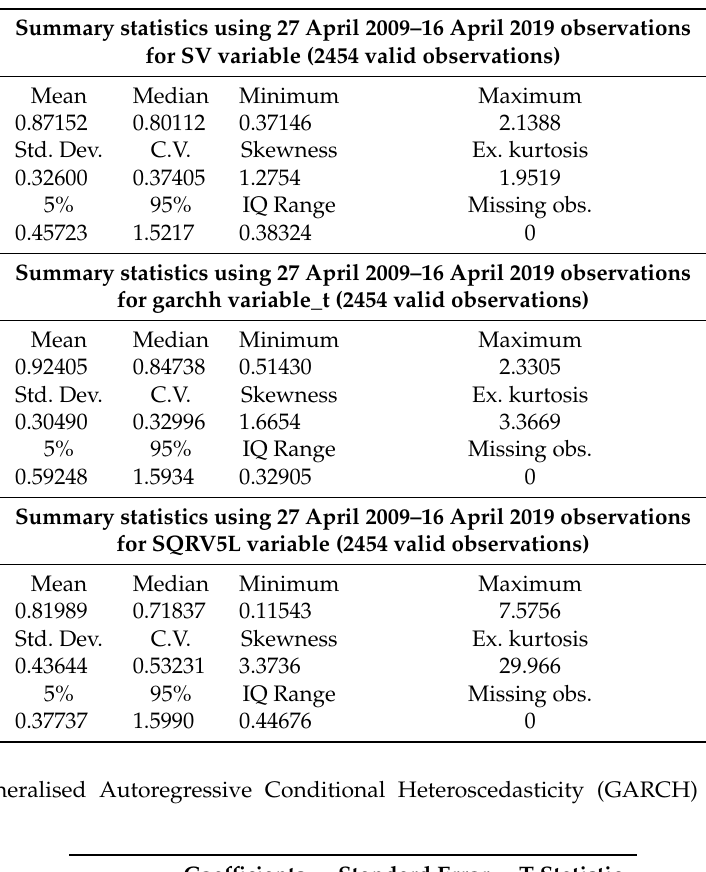
Table 3. Summary statistics: conditional volatilities from SV and GARCH(1,1) models plus SQRV5L.